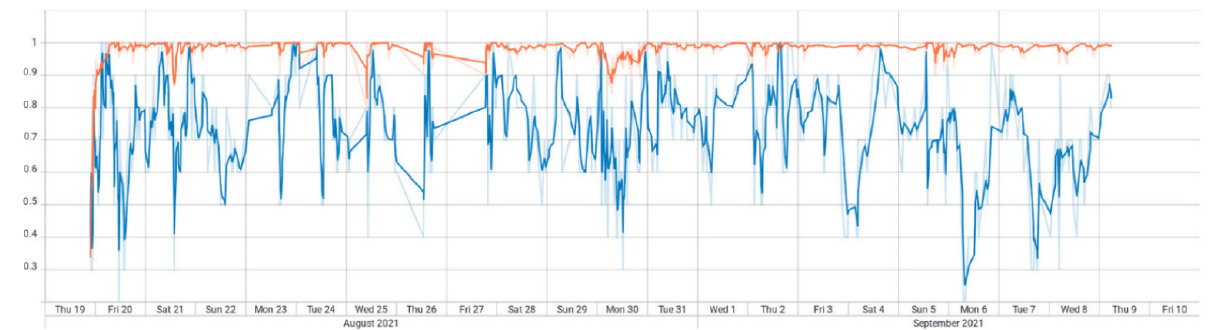
Figure 17. CNN ‐ LSTM with Stock Indicators accuracy (the orange line represents accuracy on Figure 17. CNN - LSTM with Stock Indicators accuracy (the orange line represents accuracy on training training data and the blue line accuracy on validation data) data and the blue line accuracy on validation data).